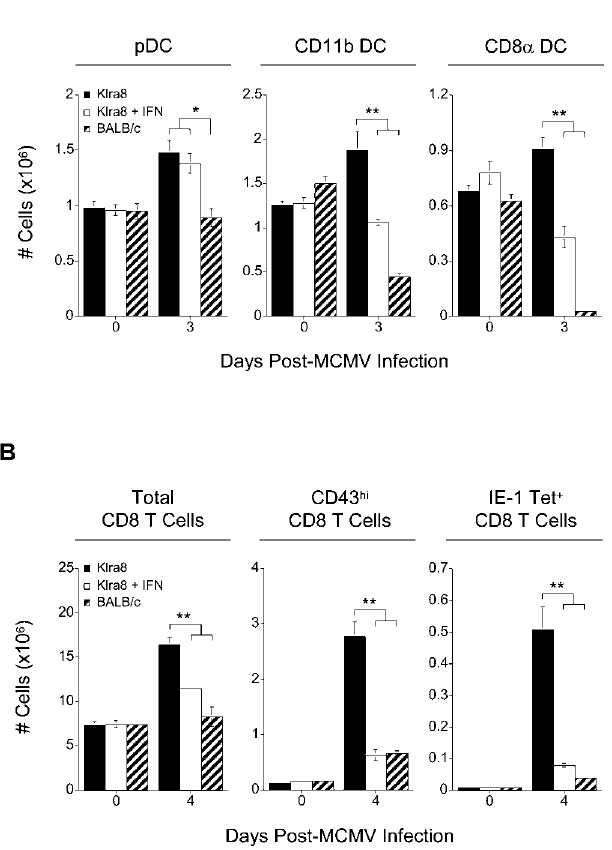
Figure 6. IFN- a -Driven Loss of cDCs and Delay in CD8 T Cell Activation (A) Splenic leukocytes were isolated on days 0 and 3 post–MCMV infection from Klra8, Klra8 treated with IFN- a at 30 and 48 h post- infection, and BALB/c mice. The total numbers (in millions) of pDCs, CD11b cDCs, and CD8 a cDCs were determined and are presented as in Figure 2. (B) Splenic leukocytes were isolated on days 0 and 4 post–MCMV infection from Klra8, Klra8 treated with IFN- a at 30 and 48 h post- infection, and BALB/c mice. Total numbers (in millions) of CD8 T cells, CD43 hi CD8 T cells, and IE-1 tetramer þ CD8 T cells were determined and are presented as in Figure 3. One experiment representative of two for (A, B) is shown. * p (cid:3) 0.05; ** p (cid:3) 0.01.